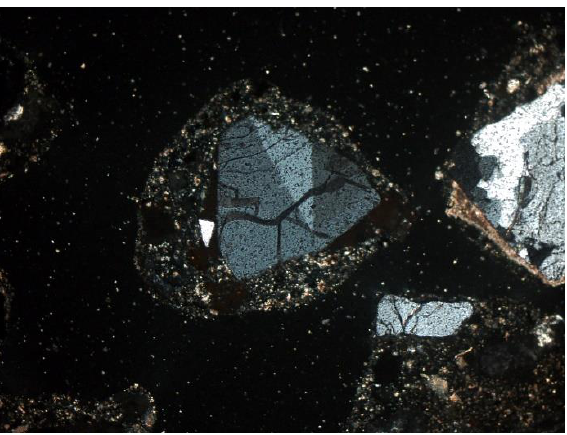
Figure 13. Potassium feldspar, and quartz, SP2 sample, thin section, 2P, 100×, transmitted light.